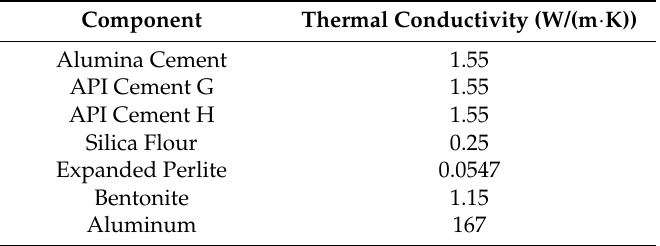
Table 6. Thermal conductivities of cement components (according to [9,11]).